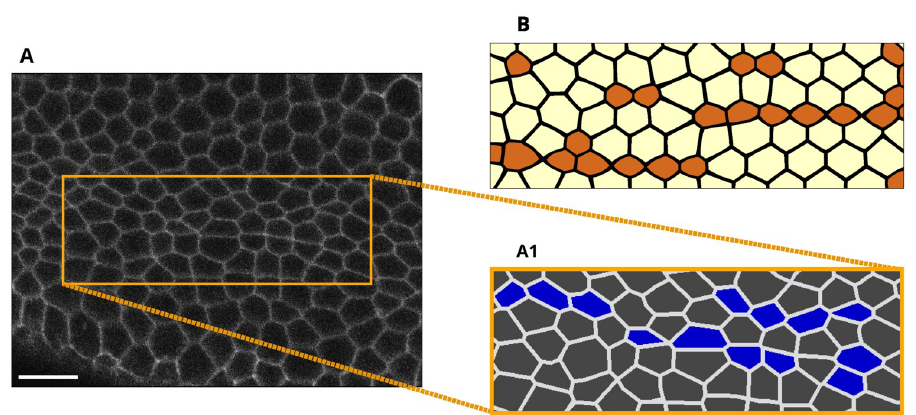
Fig 6. Elongated shapes of cells in constriction chains. ( A ) Image of the mesoderm primordium during VFF at time 175 s. Scale bar: 10 μ m. ( A1 ) Segmentation of the indicated area in (A). Constricted cells (identified using constriction cutoff r c = 0.65) are highlighted in blue. ( B ) Cell shapes predicted using the AGF model with Voronoi construction using anisotropic stress-based distance function. In both the experiment and theoretical model the constricted cells are elongated and exhibit a similar constriction